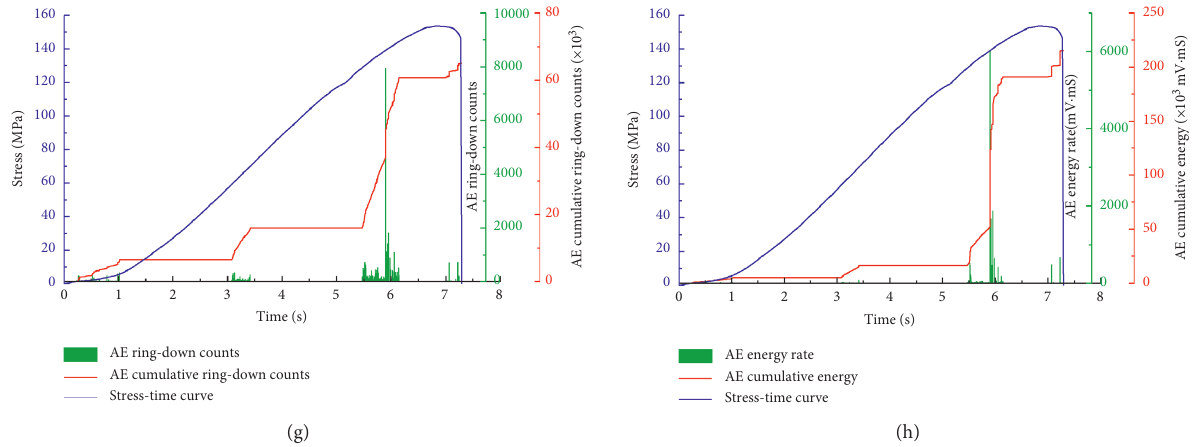
Figure 5: AE characteristics of the karst limestone under different strain rates. (a) AE ring-down counts at 5 × 10 − 6 s − 1 . (b) AE energy rate at 5 × 10 − 6 s − 1 . (c) AE ring-down counts at 2 × 10 − 5 s − 1 . (d) AE energy rate at 2 × 10 − 5 s − 1 . (e) AE ring-down counts at 1 × 10 − 4 s − 1 . (f) AE energy rate at 1 × 10 − 4 s − 1 . (g) AE ring-down counts at 5 × 10 − 4 s − 1 . (h) AE energy rate at 5 × 10 − 4 s − 1